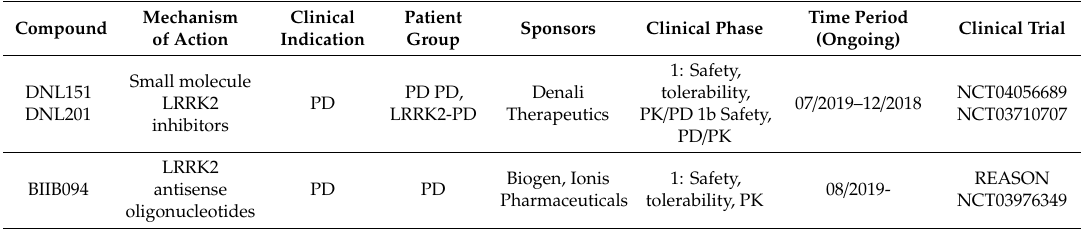
Table 2 Leucine-rich repeat kinase 2 (LRRK2)-based disease-modifying treatment strategies and their current progress in clinical trials. PK = pharmacokinetics, PD = pharmacodynamics; Clinical phases: 1 = Phase 1, clinical trials that focus on drug safety typically conducted with healthy volunteers to determine the drug’s pharmacokinetics and most frequent and serious adverse events; Phase 2, clinical trials that focus on the drug’s e ff ectiveness in patients populations while continuing to study its safety and short-term adverse